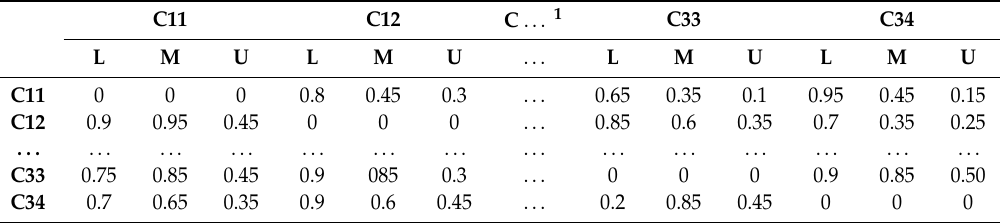
Table 5. Fuzzy direct relationship matrix between performance indicators.